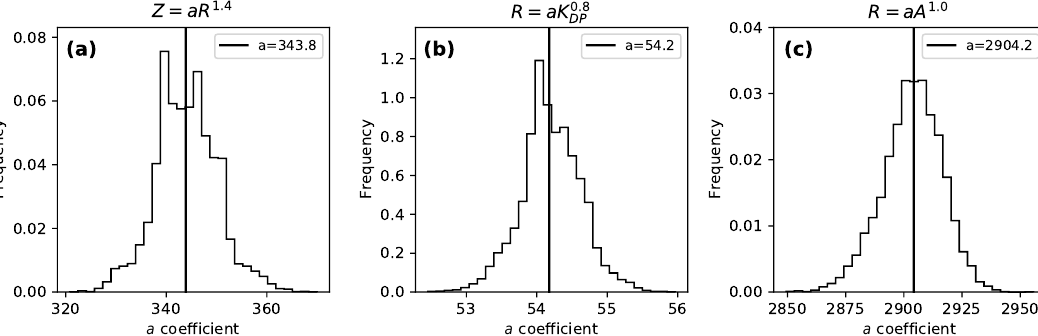
Figure 1. Histograms for a -coefficient values from single-parameter rainfall relationships (a) R ( Z ), (b) R ( K DP ) and (c) R ( A ), calculated using the least-squares method under the assumption of a fixed b coefficient from random sampling of half of the dataset (5000 times), for the S-band wavelength. The black vertical lines represent the a coefficient calculated based on the whole